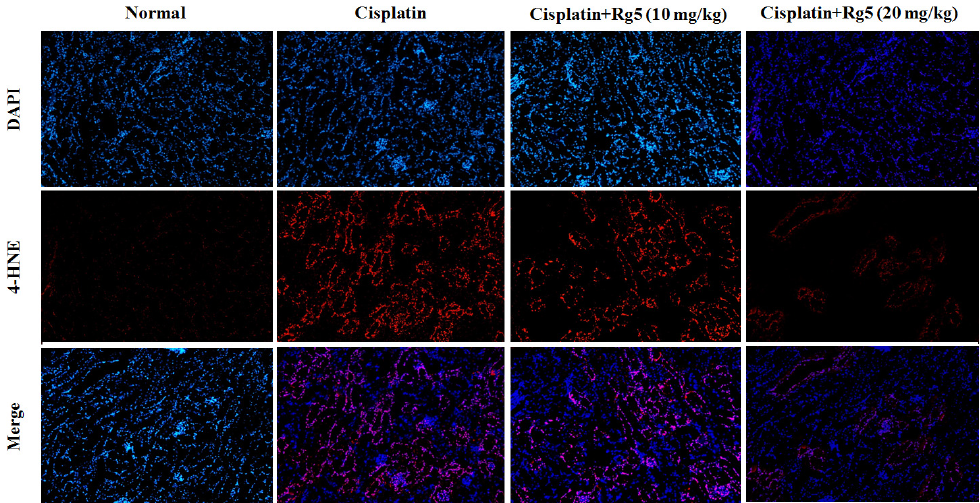
Figure 5. Effects of ginsenoside Rg5 on the expression of 4 ‐ hydroxynonenal (4 ‐ HNE). The expression